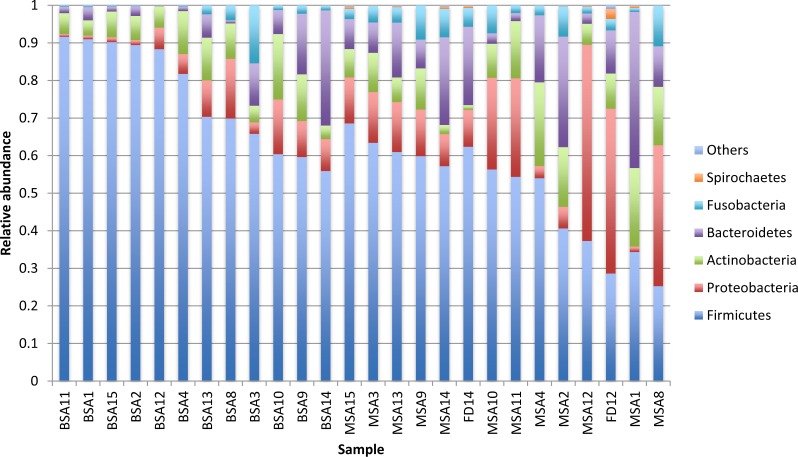
Relative abundance of the major bacterial phyla of all saliva and premasticated food samples, sorted between infant and maternal subjects.BSA, infant saliva; MSA, mother saliva; FD, premasticated food; family index numbers are the same for infant, mother and food samples.